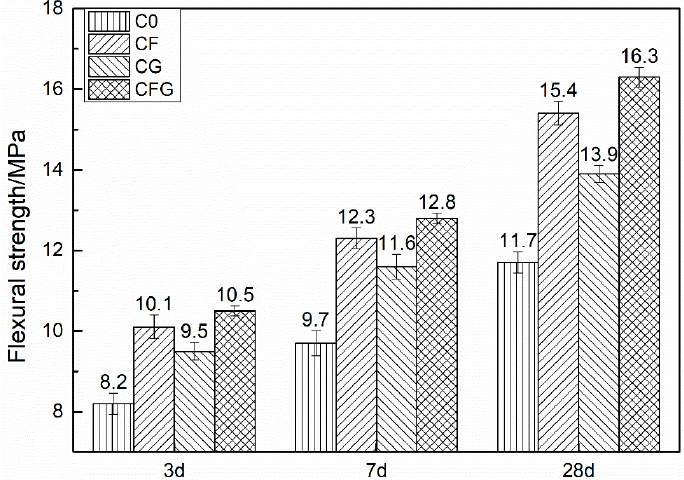
Figure 3. Flexural strength vs. curing time.